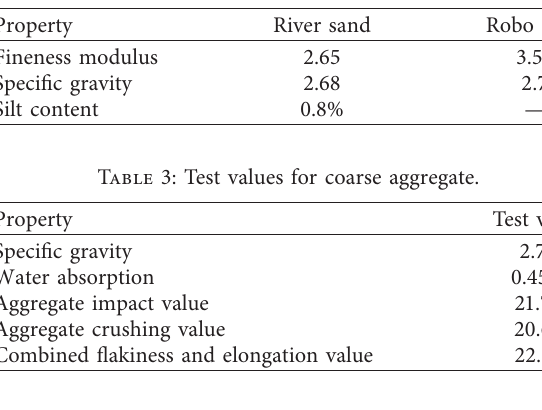
Table 2: River sand and robo sand properties.